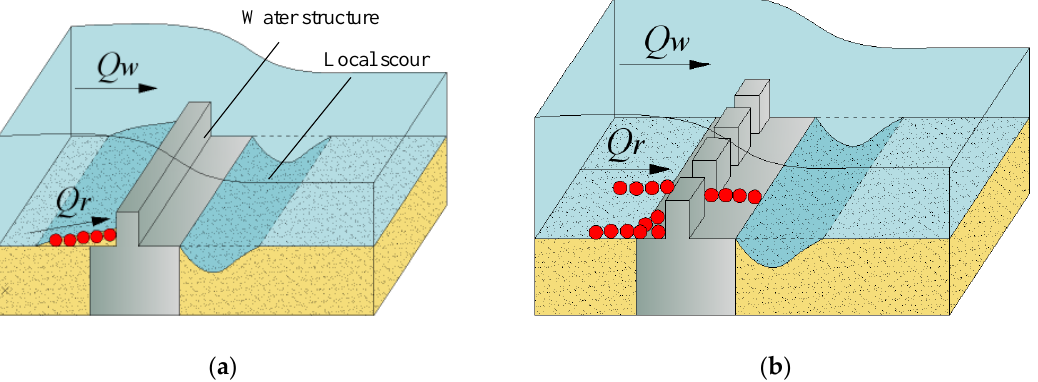
Figure 1. Sediment transport in “clear-water” ( a ) and “live-bed” ( b ) conditions, where Q w —water discharge, Q r —sediment transport intensity.